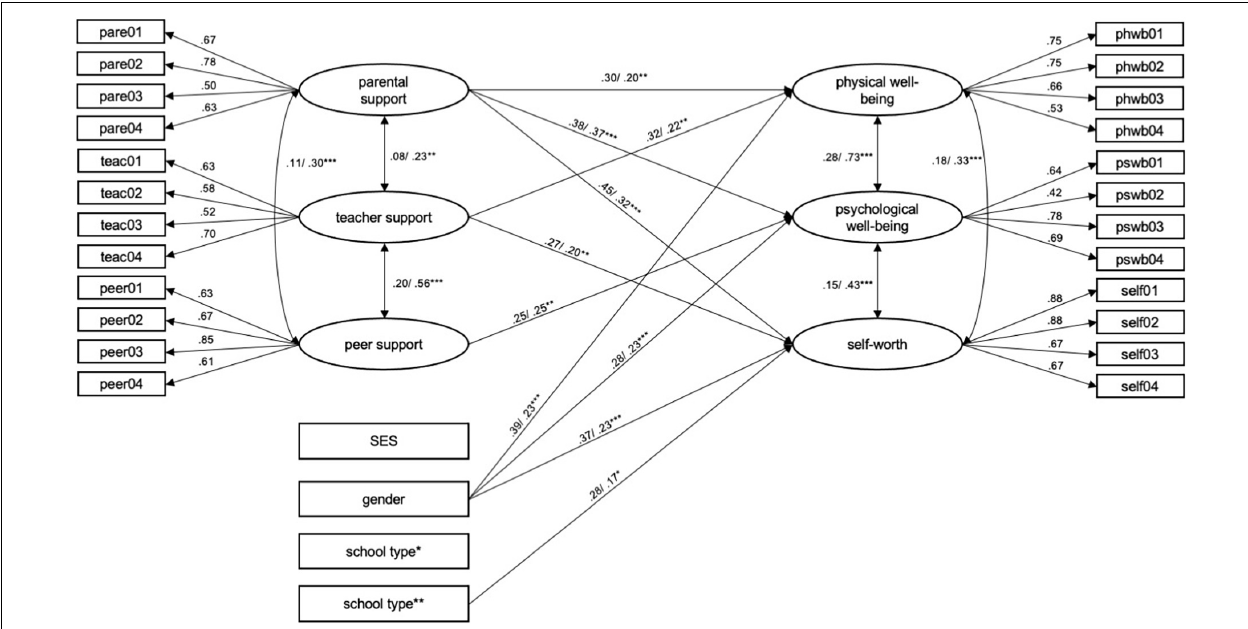
FIGURE 1 | Structural equation model for regression analysis, including control variables. Gender: female = 0, male = 1, school type* = contrasts students from low-track and high-track schools with students from mixed-track schools; school type** = contrasts students from low-track and mixed track school with students from high-track schools; coefficients are displayed unstandardized first, and standardized in second position; only significant paths are shown for clarity; * p < 0.05, ** p < 0.01, *** p <